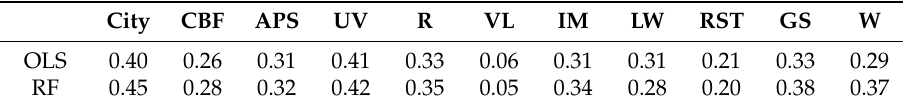
Table 4. An evaluation summary of the goodness-of-fit (R 2 ) of ordinary least squares (OLS), random forest regression